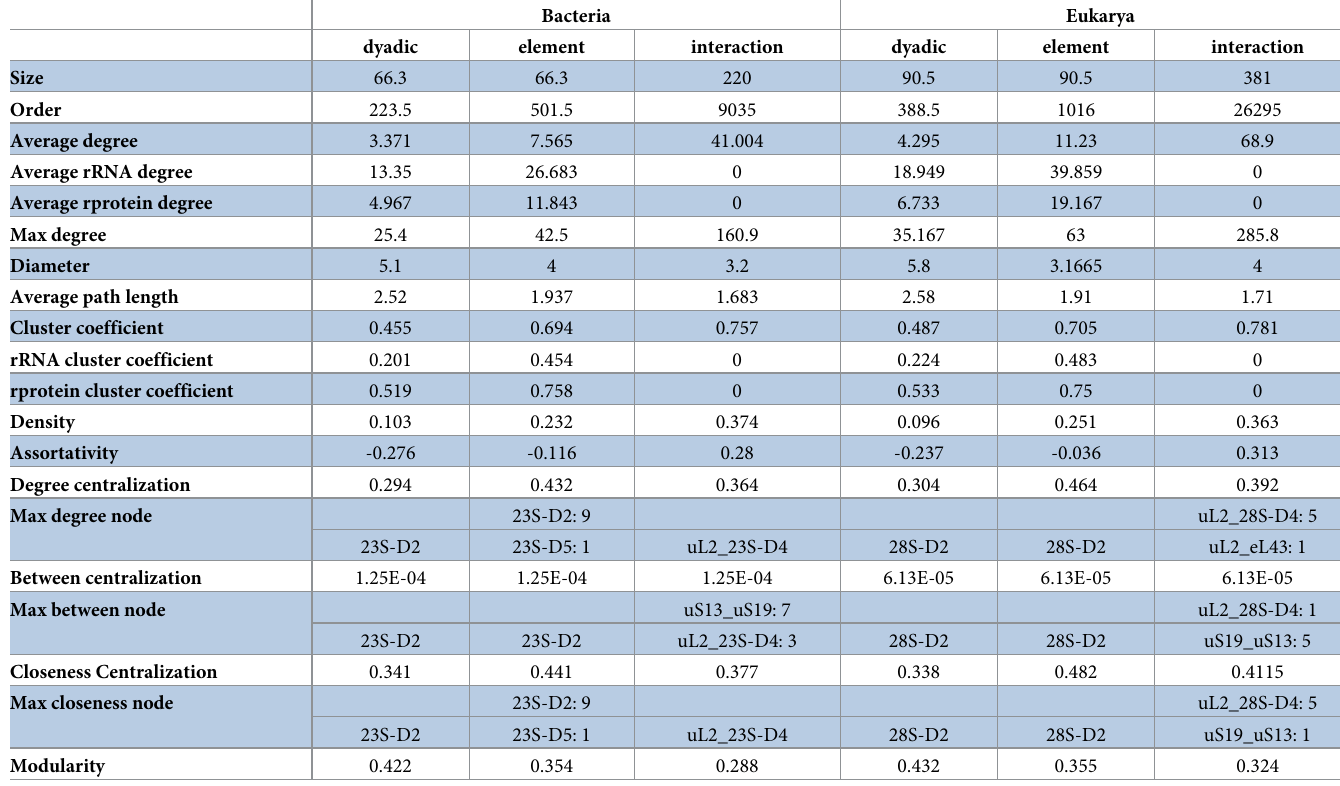
Table 3. Average basic graph properties of the three types of unipartite graphs for Bacteria and